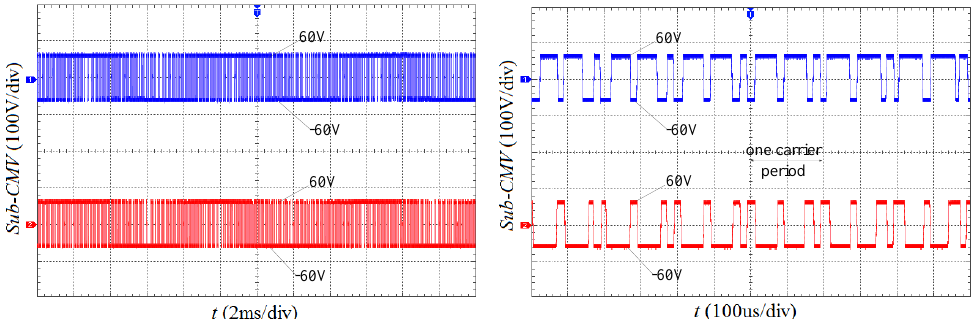
Figure 21. Experimental results of sub-CMVs for DZICMV. (Blue line denotes the V cm1 and red line denotes V cm2 )